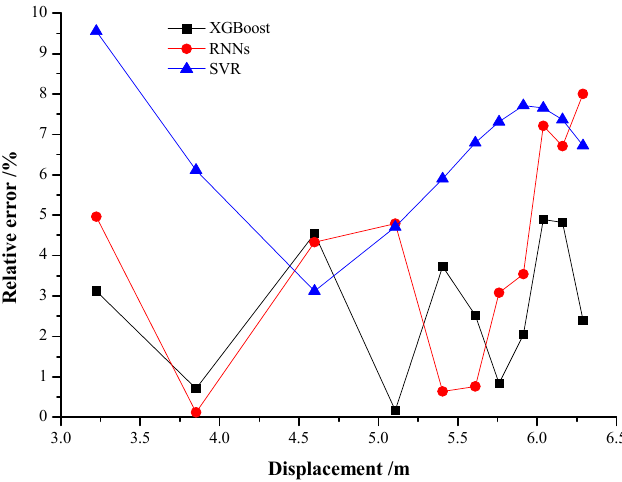
Figure 17. Variation of RE with slope displacement of D6.